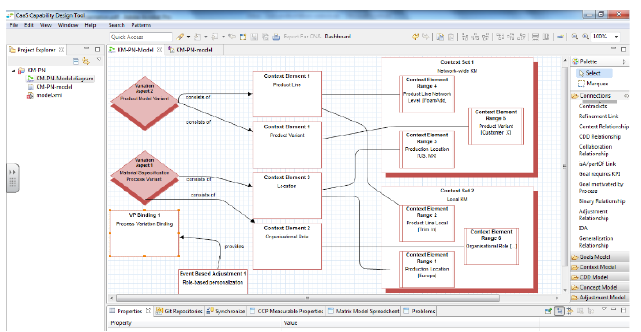
Fig. 6. Screenshot from Context Modelling Tool CDT showing the context model for the example case.